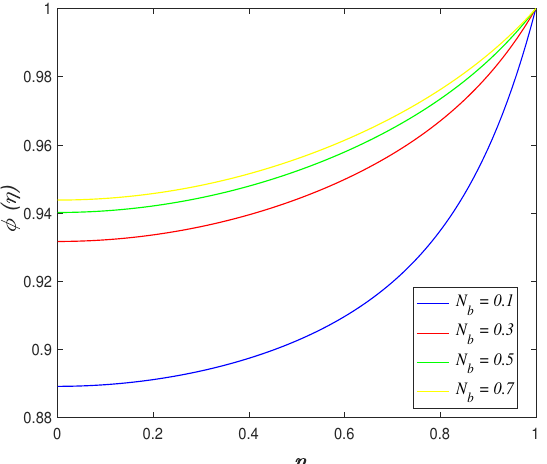
Figure 21. Impact of N b on concentration.